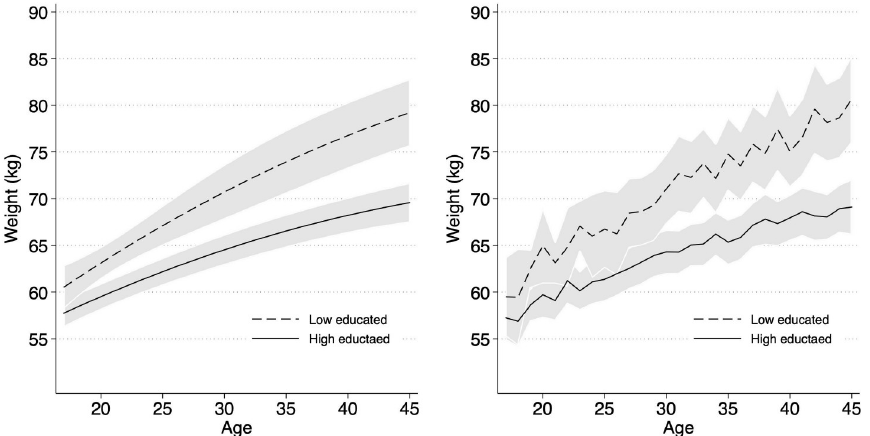
Fig 3. Predicted body weight trajectories form the preferred parametric model specification and from a semi- parametric model specification. Data are from SOEP, v.34; own calculations; (a) predicted body-weight